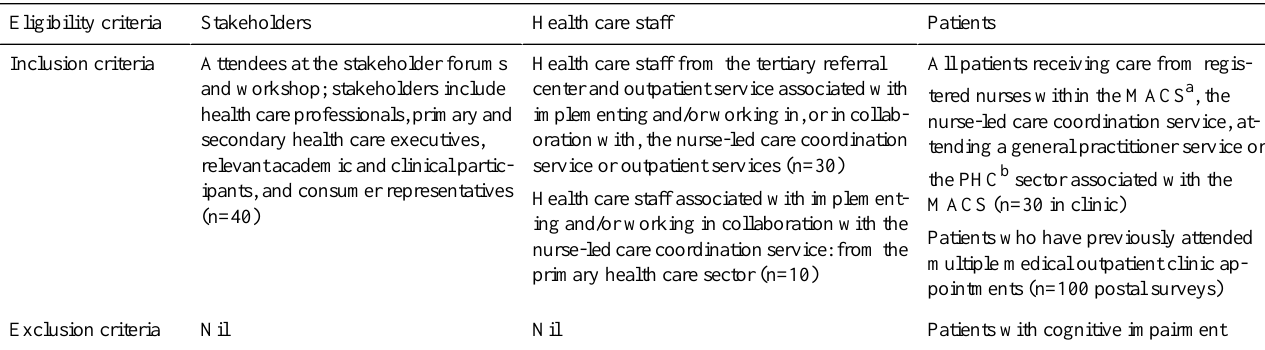
Table 1. Study participants and eligibility